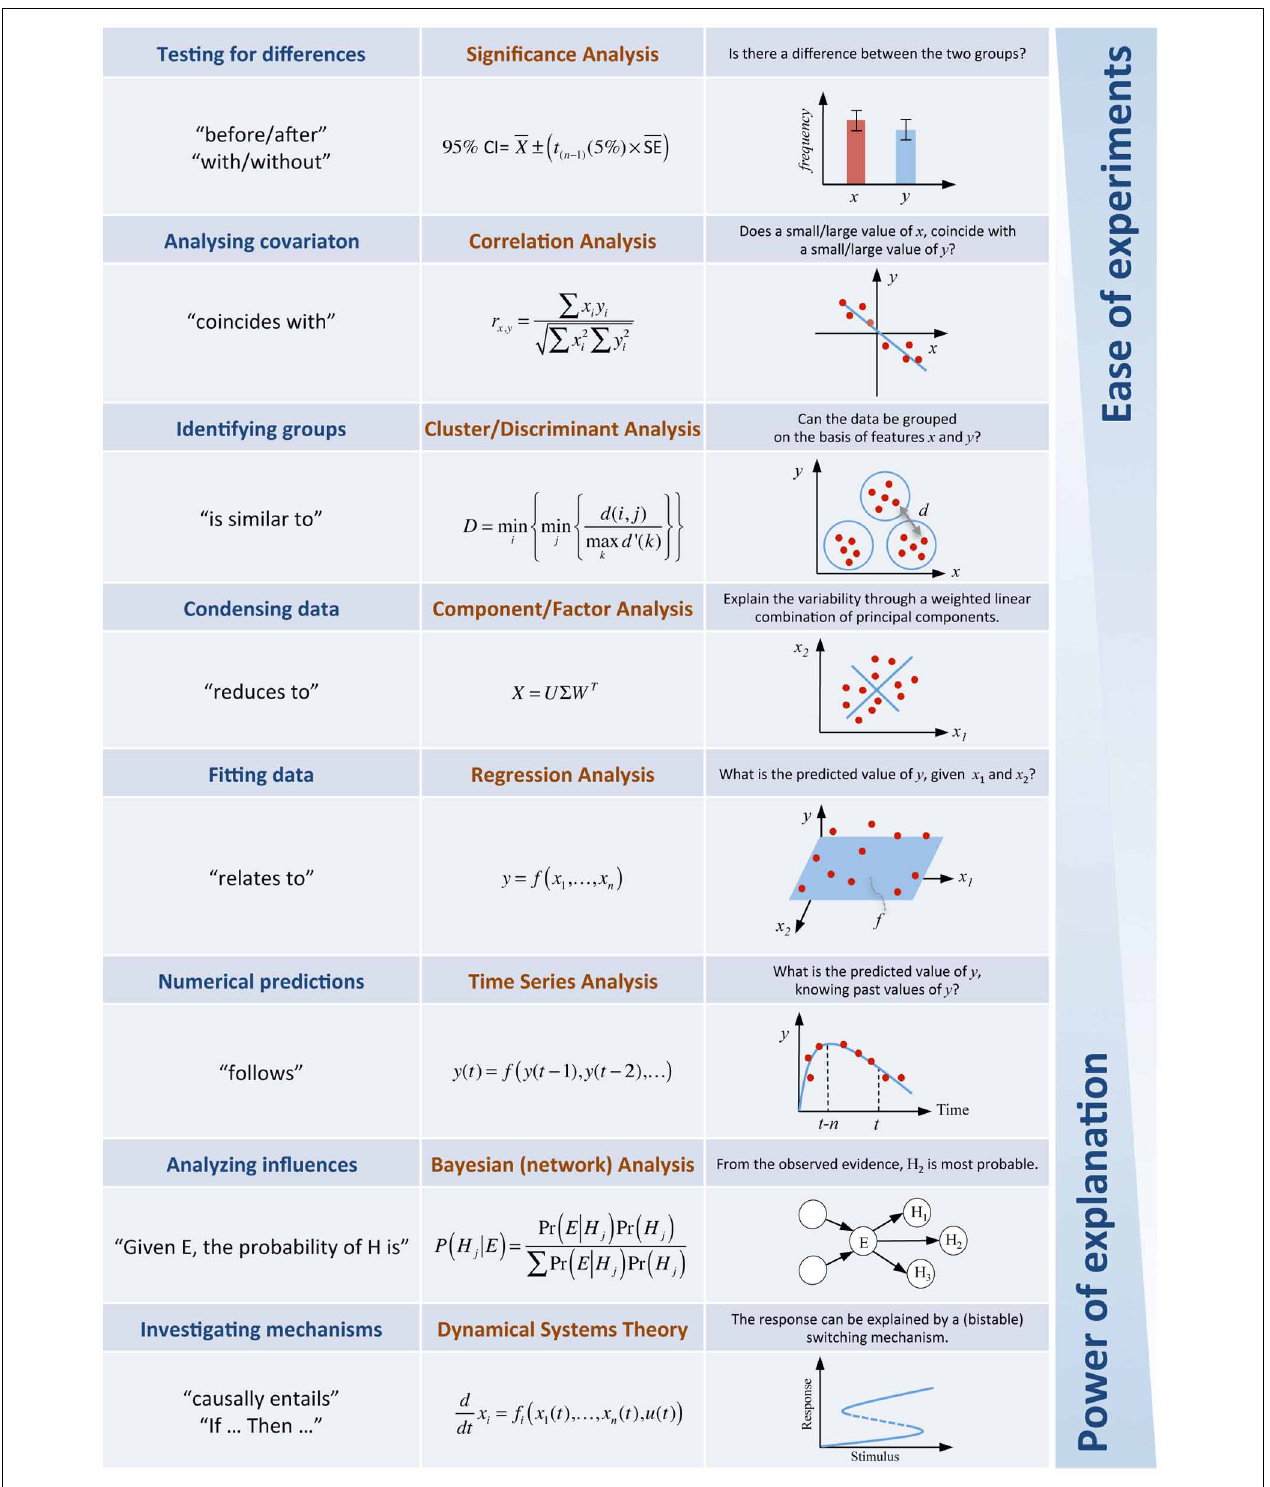
FIGURE 1 | Answering biological questions through mathematical analyses. The table illustrates a selection of approaches available in systems biology. In practice, the vast majority of questions in experimental biology concern “differences.” Given that experimental observations vary, statistical testing will establish the significance of a difference. The experiments for this type of question are easy to conduct